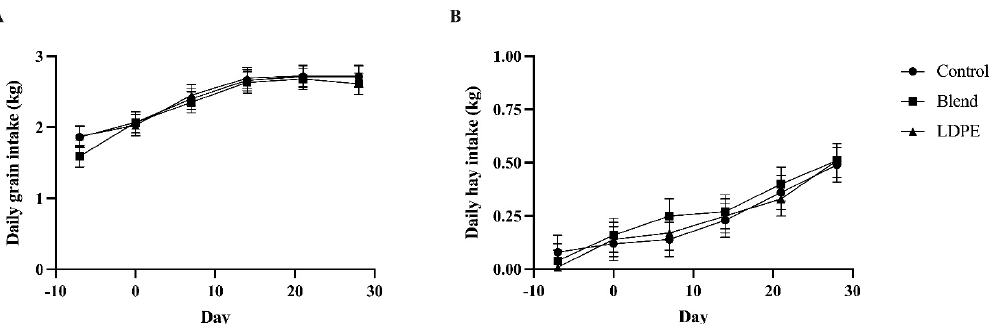
Figure 1. Average daily feed intake determined on a weekly basis, as fed, of Holstein bull calves given either empty gelatin capsules (Control), 13.6 g of a poly(butylene succinate- co -adipate) and polyhydroxyalkanoate melt-blend (Blend), or 13.6 g of low-density polyethylene (LDPE) for 30 d, separated by average daily grain intake ( A ) and average daily hay intake ( B ). For grain intake, Treatment: p = 0.35; Day: p < 0.01; Treatment x Day: p = 0.61. For hay intake, Treatment: p = 0.84; Day: p < 0.01; Treatment x Day: p = 0.58. Data are shown as least-squared means of treatments within time (LSM ± SEM).